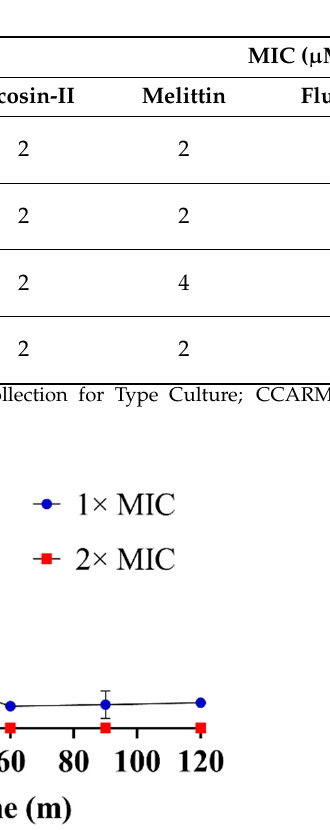
Figure 1. The time-kill kinetics curves of Lycosin-II against Candida albicans . C. albicans (Korea Collection for Type Culture 7270) was exposed to Lycosin-II for 0, 1, 5, 10, 20, 30, 60, 90, and 120 min. The survival rates were determined by counting the number of colony-forming units at each time point. Abbreviation: MIC, minimum inhibitory